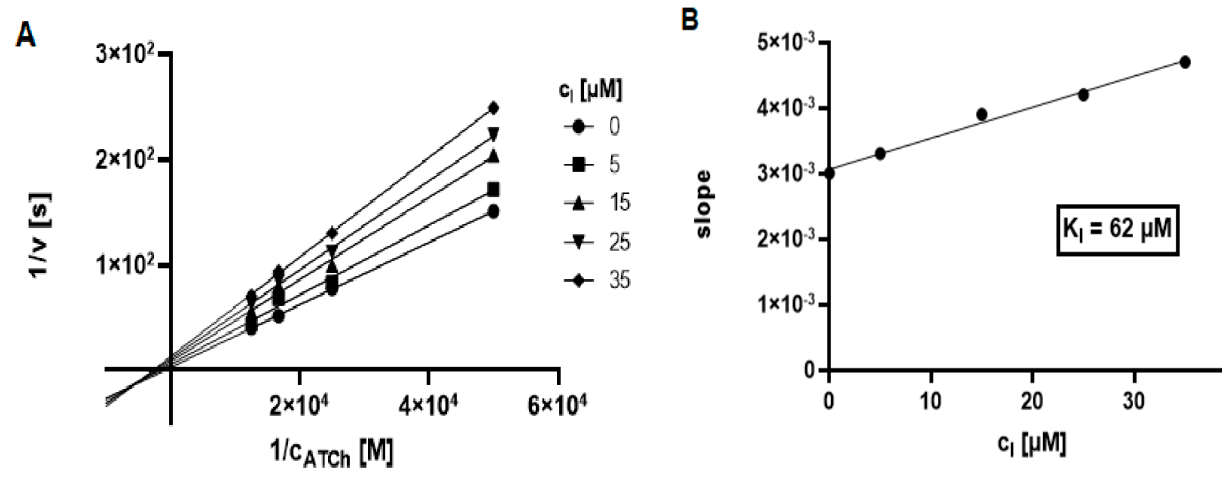
Figure 4. Lineweaver–Burk plot for compound 7 inhibiting AChE. The measurements were performed in duplicate and the points are expressed as average values ( A ). Dependence of the slope (Lineweaver–Burk plot) vs. concentration of inhibitor (combination AChE- 7 ) ( B ).